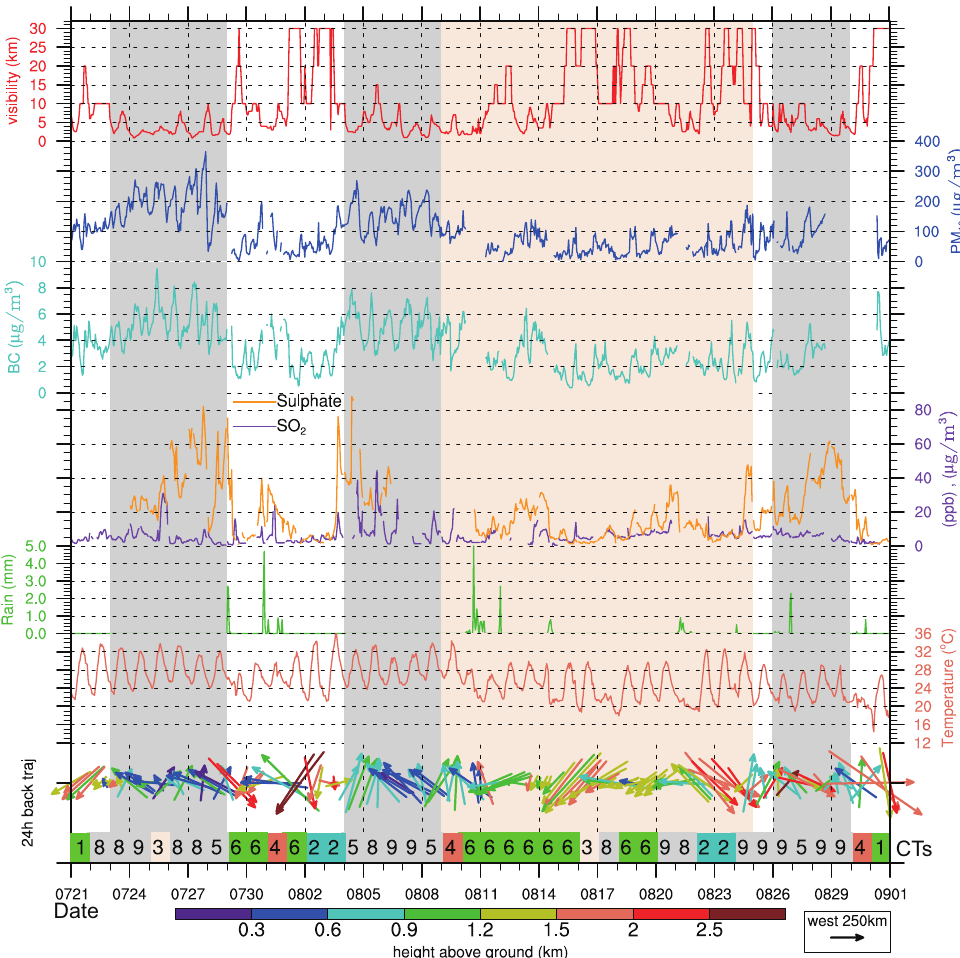
Fig. 11. Time series of (top to bottom) hourly visibility, PM 10 , BC, sulfate and SO 2 , surface temperature, precipitation, and the 24-h backward plume position at 6-h intervals (direction and distance shown as arrows, height above ground shown in colors) and daily circulation types (CTs) from 21 July to 31 August 2008. Pink shading indicates the period of the Olympic Games, while gray shading represents the pollution episodes in Beijing.